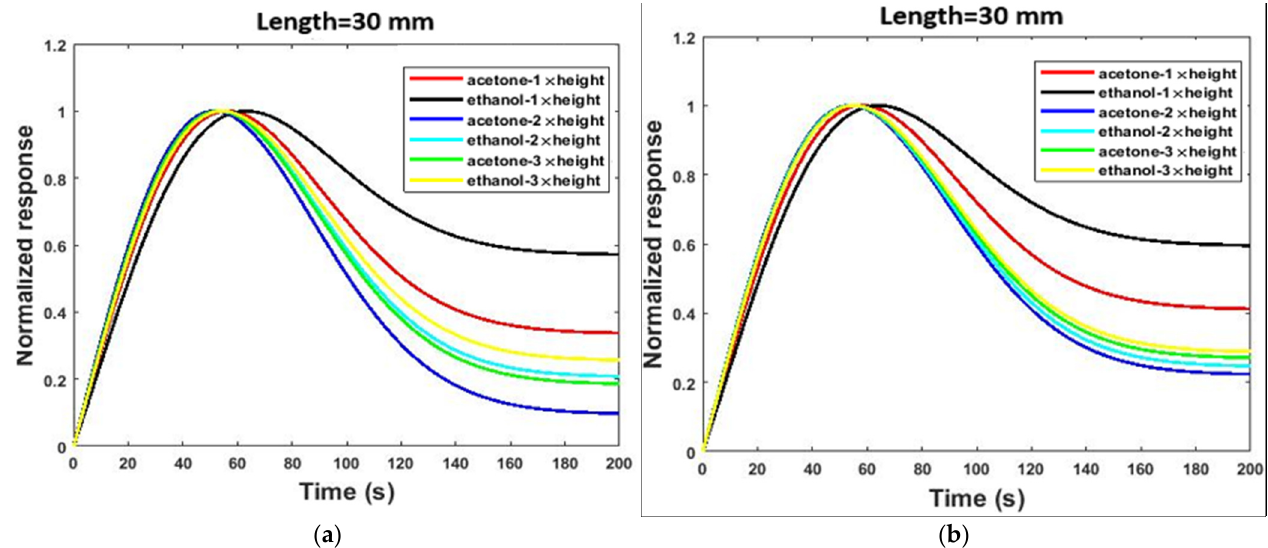
Figure 11. The effect of cross-section variation of the channel on the selectivity of the sensor in the presence of 2.6 ppm acetone and ethanol gases in both the serpentine and simple models: ( a ) serpentine, ( b ) simple. Table 3. Comparison of calculated selectivity (S AB ) by changing channel height of the sensor in the presence of 2.6 ppm acetone and ethanol gases in both the serpentine and simple models.